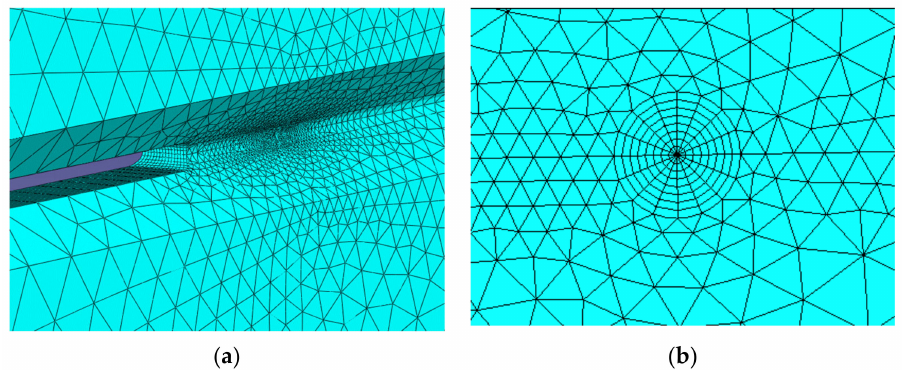
Figure A2. Finite element mesh of a specimen with grooves ( a ) and arrangement of elements along the crack front for the calculation of stress intensity factors ( b